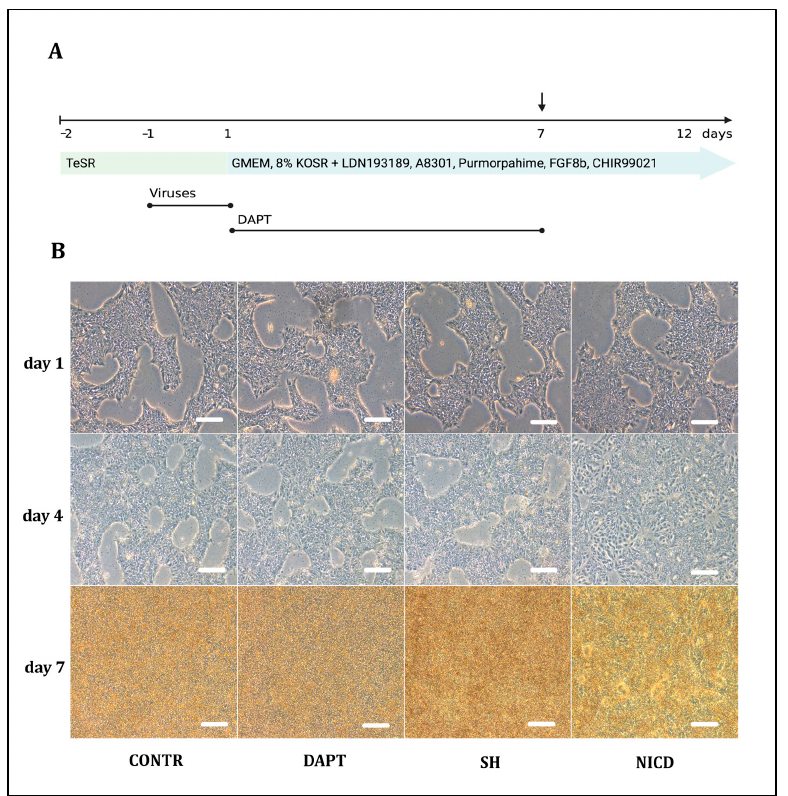
Figure 1. Modulation of Notch signaling during early stages of differentiation of human induced pluripotent stem (hIPS) cells to dopaminergic (DA) neurons. ( A ) the experiment scheme; viral particles were added on the next day after cell seeding and incubated for 24 h. DAPT was added from days 1 to 7 of differentiation. Cells were taken for RNA isolation on day 7 of differentiation. Created in BioRender.com; ( B ) transmitted light, 4 conditions: CONTR, non ‐ treated cells; DAPT, cells treated with DAPT; SH, cells with RBPJ knockdown; NICD, cells with NICD overexpression. Morphological changes in cell culture on days 1, 4, 7 of differentiation of hIPS cells to DA neuron with modulation of Notch signaling showed similarity in CONTR, SH and DAPT conditions and differences in NICD condition, which manifested with the formation of rosette like structures starting from day 4. Scale bars 200 μ m.